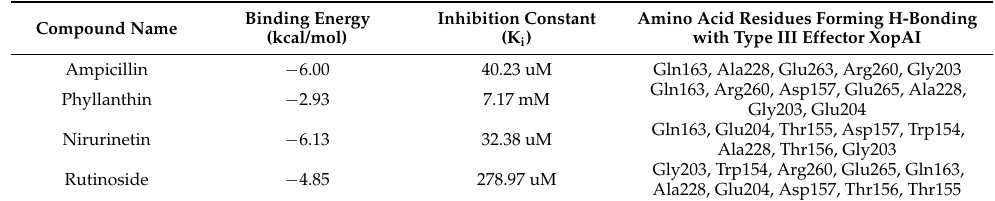
Table 2. Docking results of ligands with type-III effector XopAI.